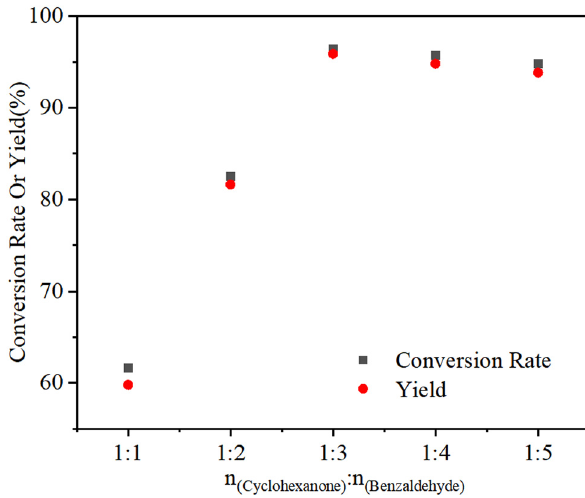
Figure 9: The e ff ect of the amount of benzaldehyde on the ε - caprolactone yield. Reaction conditions: cyclohexanone ( 0.02 mol ) , 1,2 - dichloroethane ( 30 mL ) , Fe – Sn – O ( 0.12 g ) , O 2 ( 20 mL min − 1 ) , 55°C, 5 h.